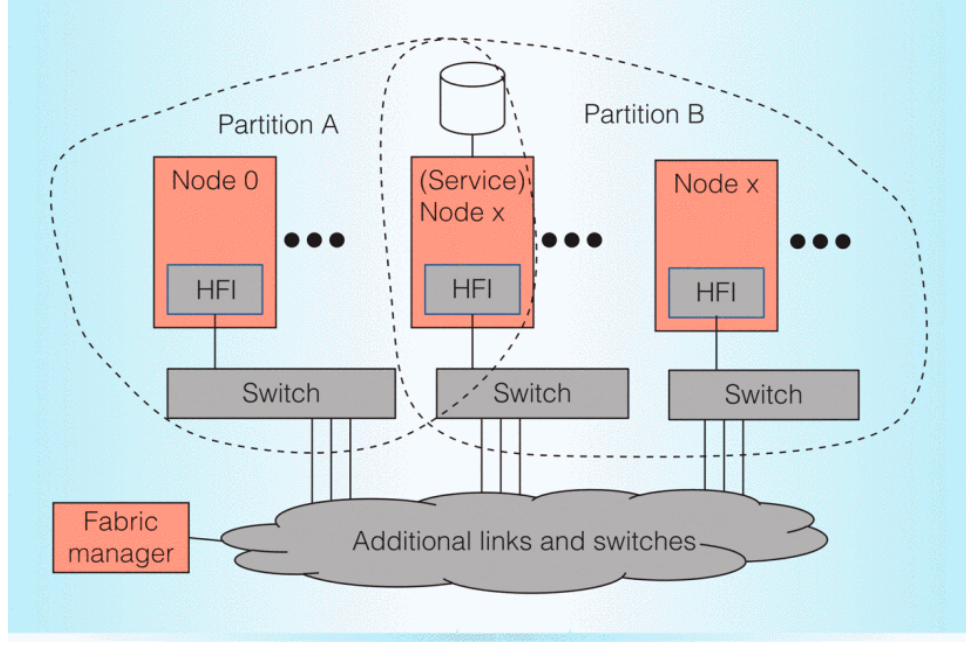
Figure 4. Intel Omni-Path Architecture (OPA) elements [7].